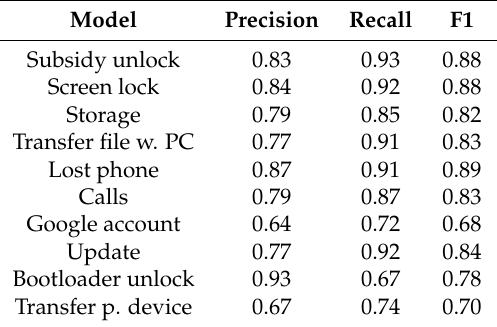
Table 5. Intent category classification results for user question, top 10 categories.